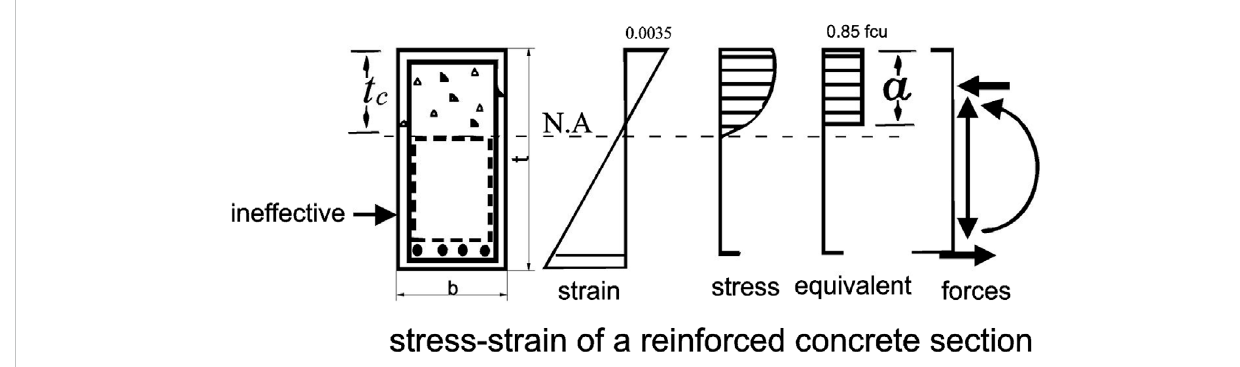
FIGURE 1 Theoretical stress and strain of the composite section when t c > a.